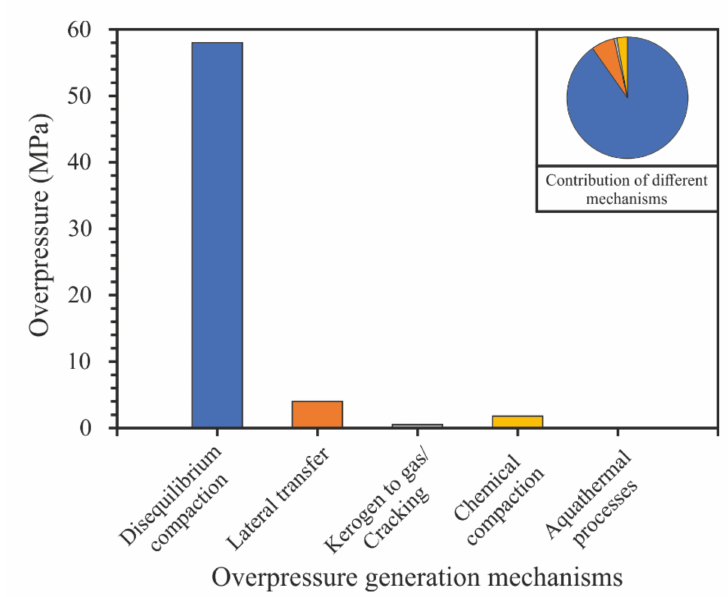
Figure 15. Maximum contribution of the different overpressure generation mechanisms based on the simulated two sections. Models suggest that the lateral transfer, chemical compaction, and the hydrocarbon generation have only minor roles in the development of the subsurface pressure